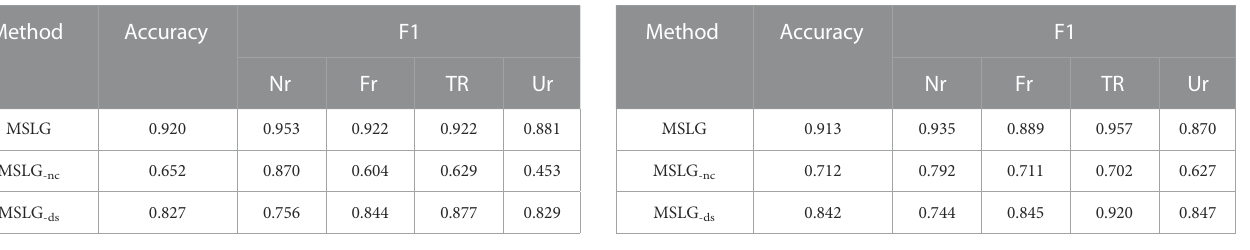
TABLE 5 Ablation experiment results on Twitter15 dataset. TABLE 6 Ablation experiment results on Twitter16